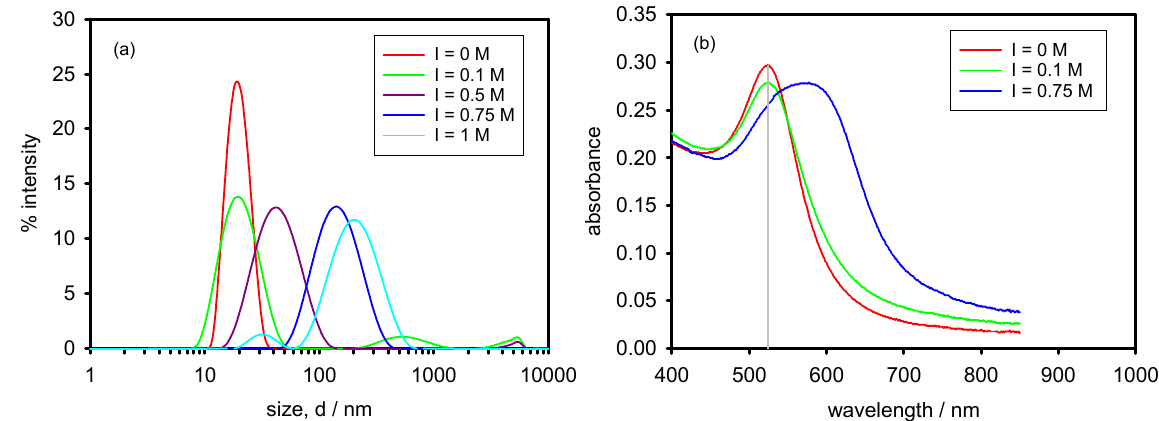
Figure 2. ( a ) Size distributions by intensity of AuNPs in varying NaCl concentration. ( b ) UV-vis spectra of AuNPs in varying NaCl concentration. Measurements were performed 24 h after salt addition and at 25 °C.